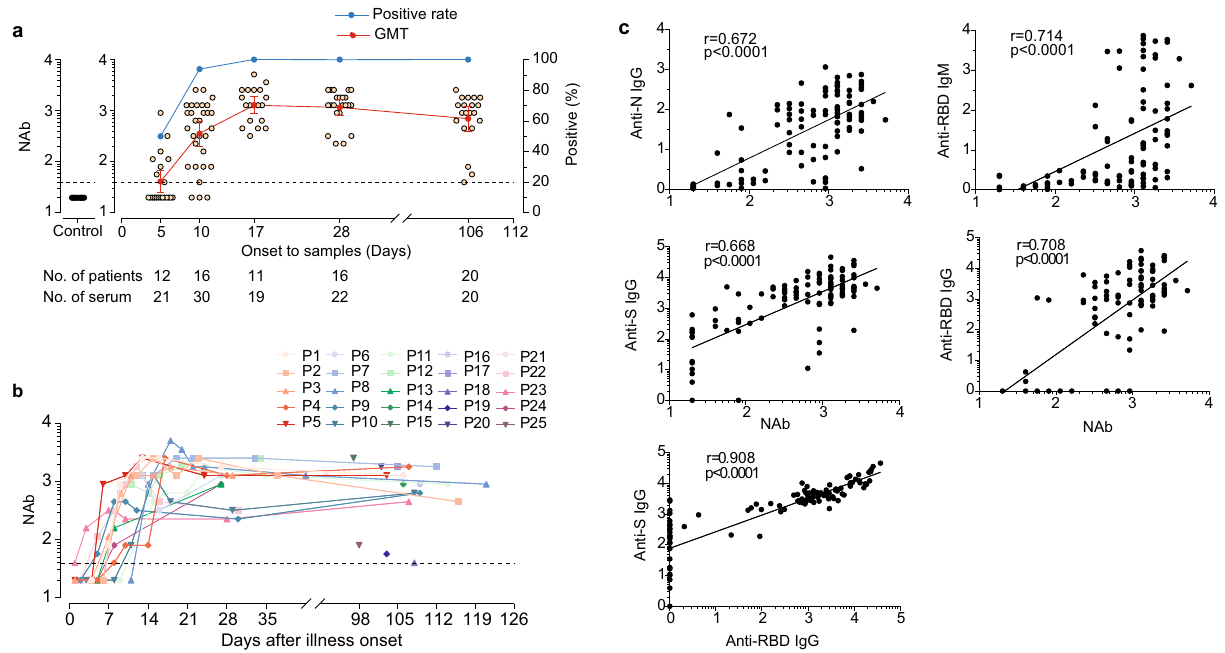
Fig. 2 SARS-CoV-2 live-virus neutralisation antibody titre in serum and correlation with IgG and IgM responses. a The percentages of patients with serum samples that were positive for neutralising antibody (NAb) and log10-transformed geometric mean titer (GMT). Error bars represent 95% con fi dence interval. Each circle represents the titer for a serum sample. b Individual NAb titer in serum samples collected from patients, and the samples from the same patients are connected by the lines. c Correlations between SARS-CoV-2-speci fi c NAb titer and anti- nucleoprotein (N), -spike (S), and -receptor-binding domain (RBD) IgG levels and anti-RBD IgM, and the correlation between anti-S IgG and anti-S IgG. Statistical comparisons were performed using the two-sided nonparametric Spearman correlation. p value and spearman ’ s rho are presented. p = 4.79E-16, 9.93E-19, 8.46E-16, and 2.76E-18 for anti-N IgG, anti-RBD IgM, anti-S IgG, and anti-RBD IgG with NAb correlation, respectively, and p = 1.78E-43 for anti-S IgG with anti-RBD IgG correlation. Source data included as a Source Data CD4 + and CD8 + T cell responses to SARS-CoV-2 in recovered